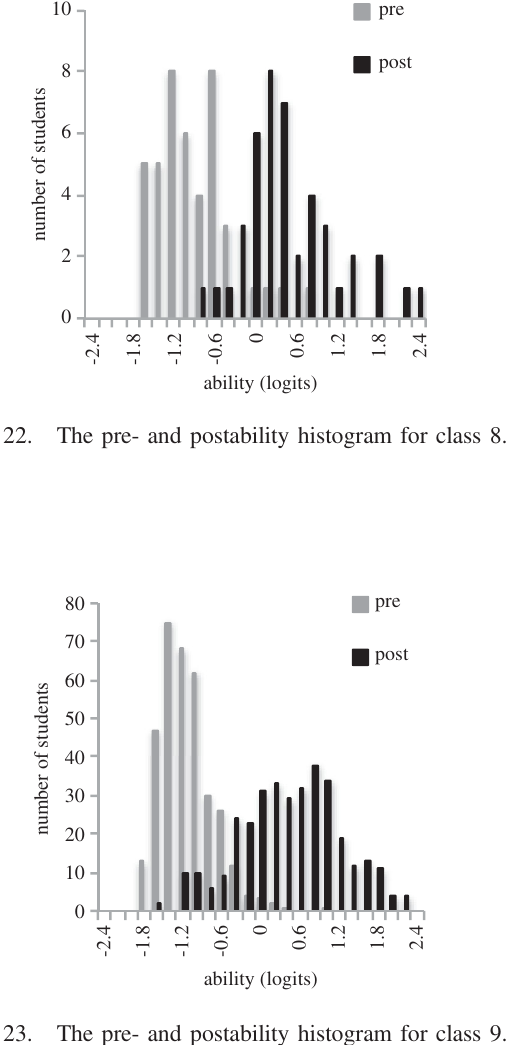
FIG. 23. The pre- and postability histogram for class 9.